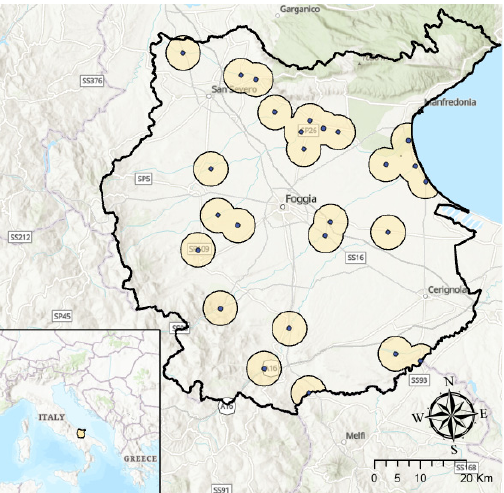
Figure 1. Study area (water basin in the Foggia province) with the surface water monitoring stations and the corresponding 5 km buffer.